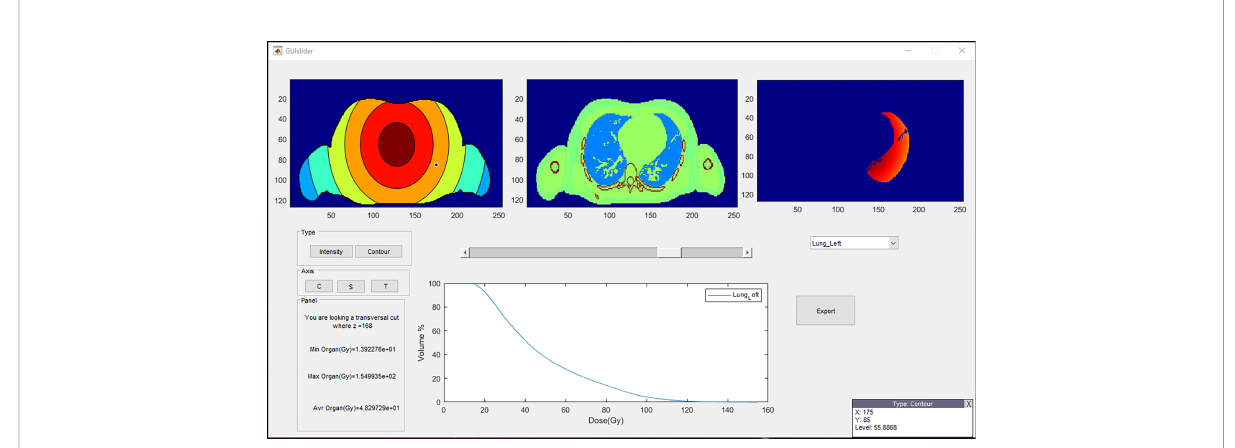
FIGURE 9 A representative visualization of the Periphocal 3D ’ s GUI. The three upper boxes can be displayed as transversal (T), coronal (C), or sagittal (S) views. The upper-left box represents the peripheral dose normalized to the maximum (which is always displayed in red) (i.e., the red color might represent a different level of dose at each different slice), and the central box is the anatomical information. The upper-right box represents the dose distribution of the chosen organ (lung in this example) from the list of all contoured organs. Its corresponding cumulative DVH is displayed in the plot below. The DVH can be exported as an ASCII fi le. The lower-left box informs the value of the z coordinate, together with the maximum, minimum, and average dose of the chosen organ. The user can fi nally move around the upper-left and central boxes so that the coordinates and dose level (in mGy/Gy) of the cursor are displayed in the lower-right box. The GUI can be shared with those who request